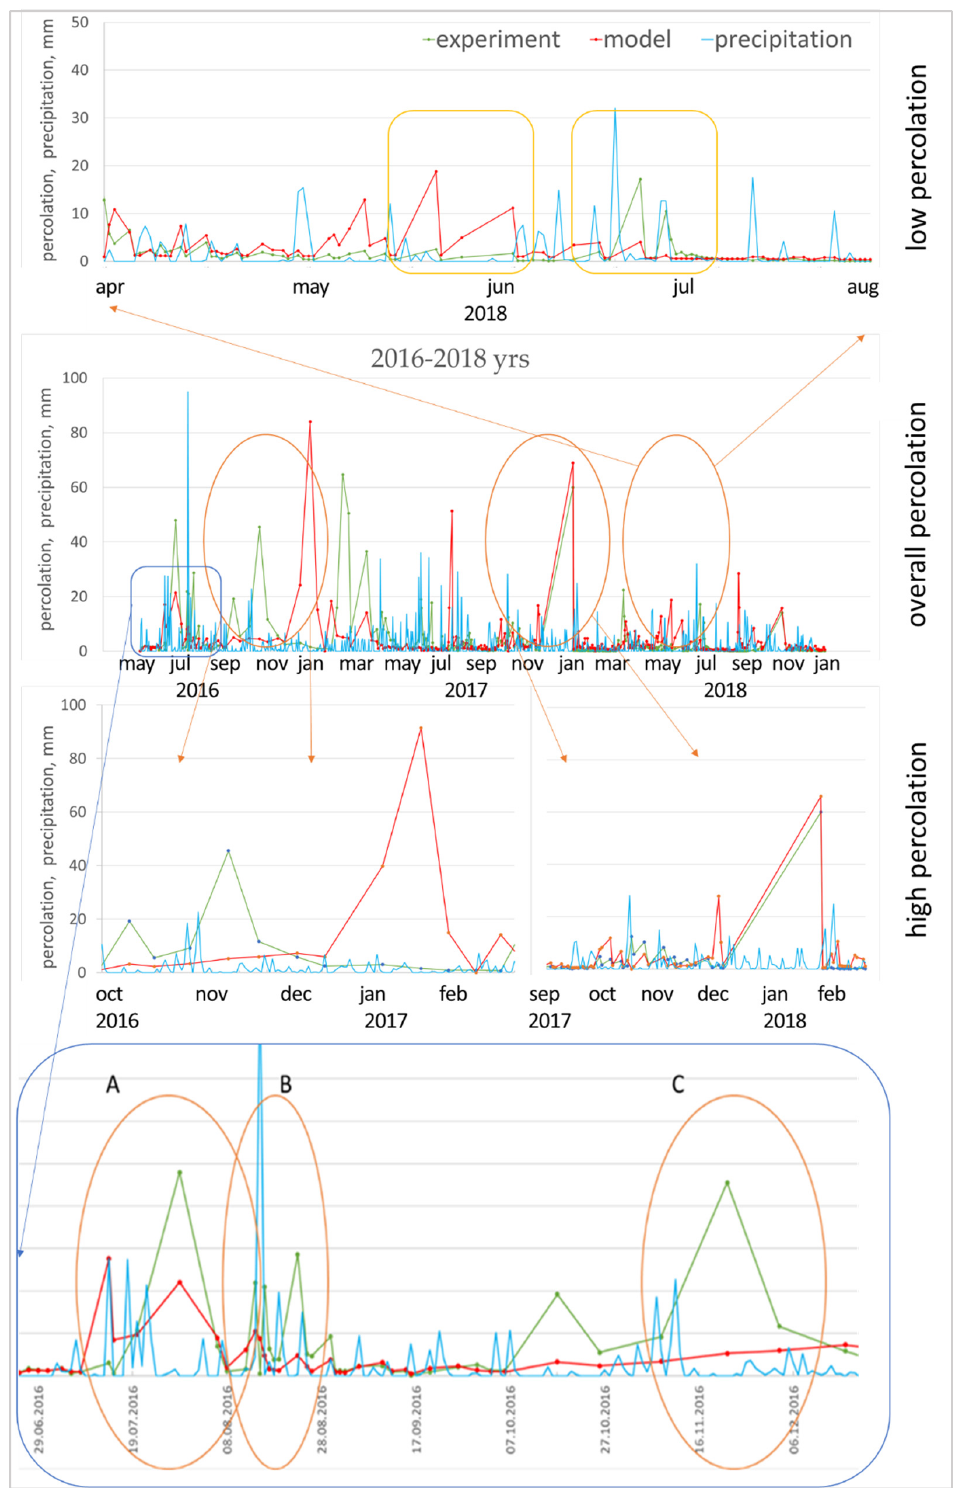
Figure 7. Measured and predicted percolation in different periods of the study: ( A ) several excess peaks during heavy precipitation; ( B ) underestimation of percolation peaks during heavy but slow rains; ( C ) periods with several dry days after intense rainfall, which again end in precipitation.